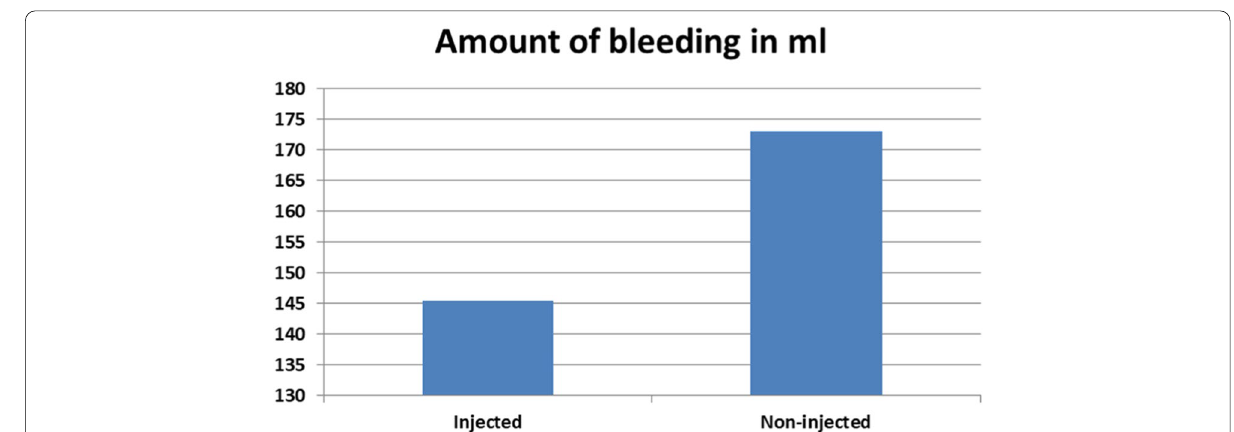
Fig. 6 Comparison between injection and non‑injection side as regards amount of